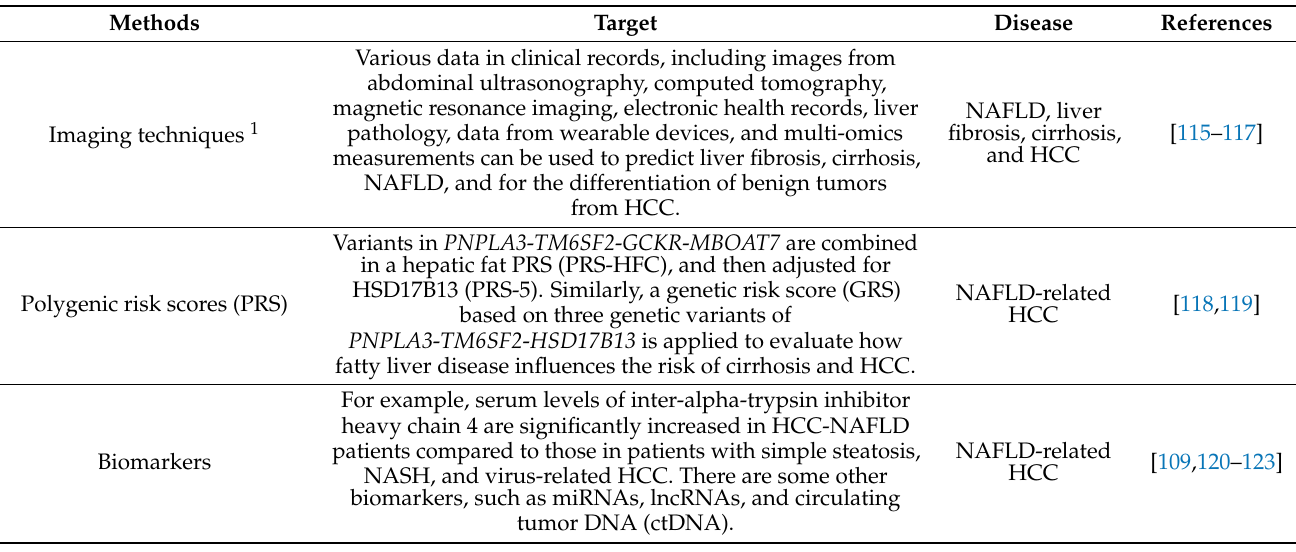
Table 1. The potential HCC diagnostic